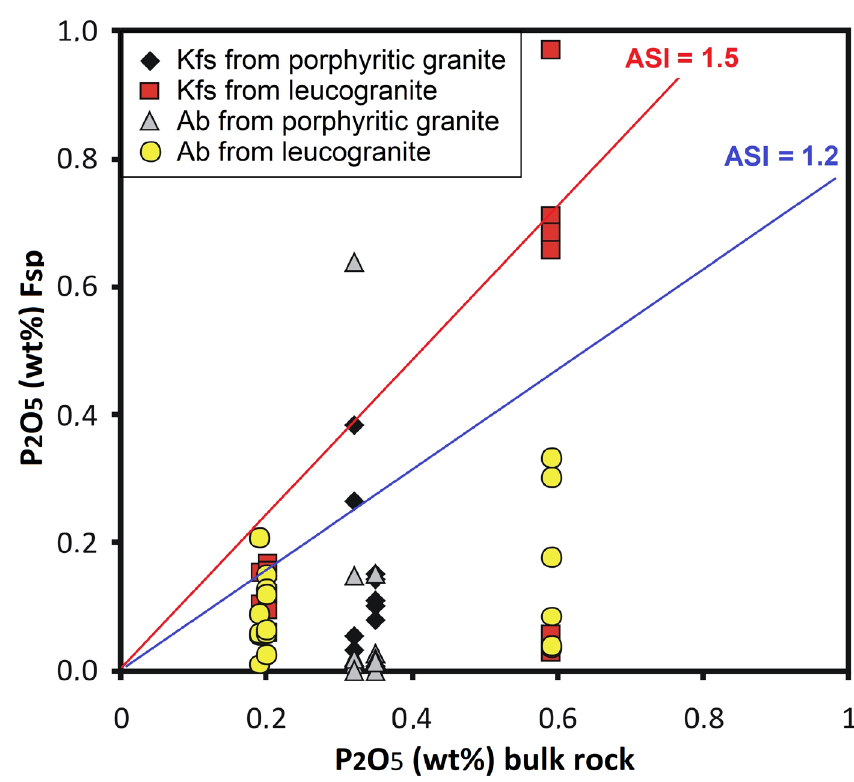
Figure 9. The contents of phosphorus in alkali feldspars. The contents of P 2 O 5 in magmatic feldspar are a function of bulk P contents and the peraluminity of the melt [39].